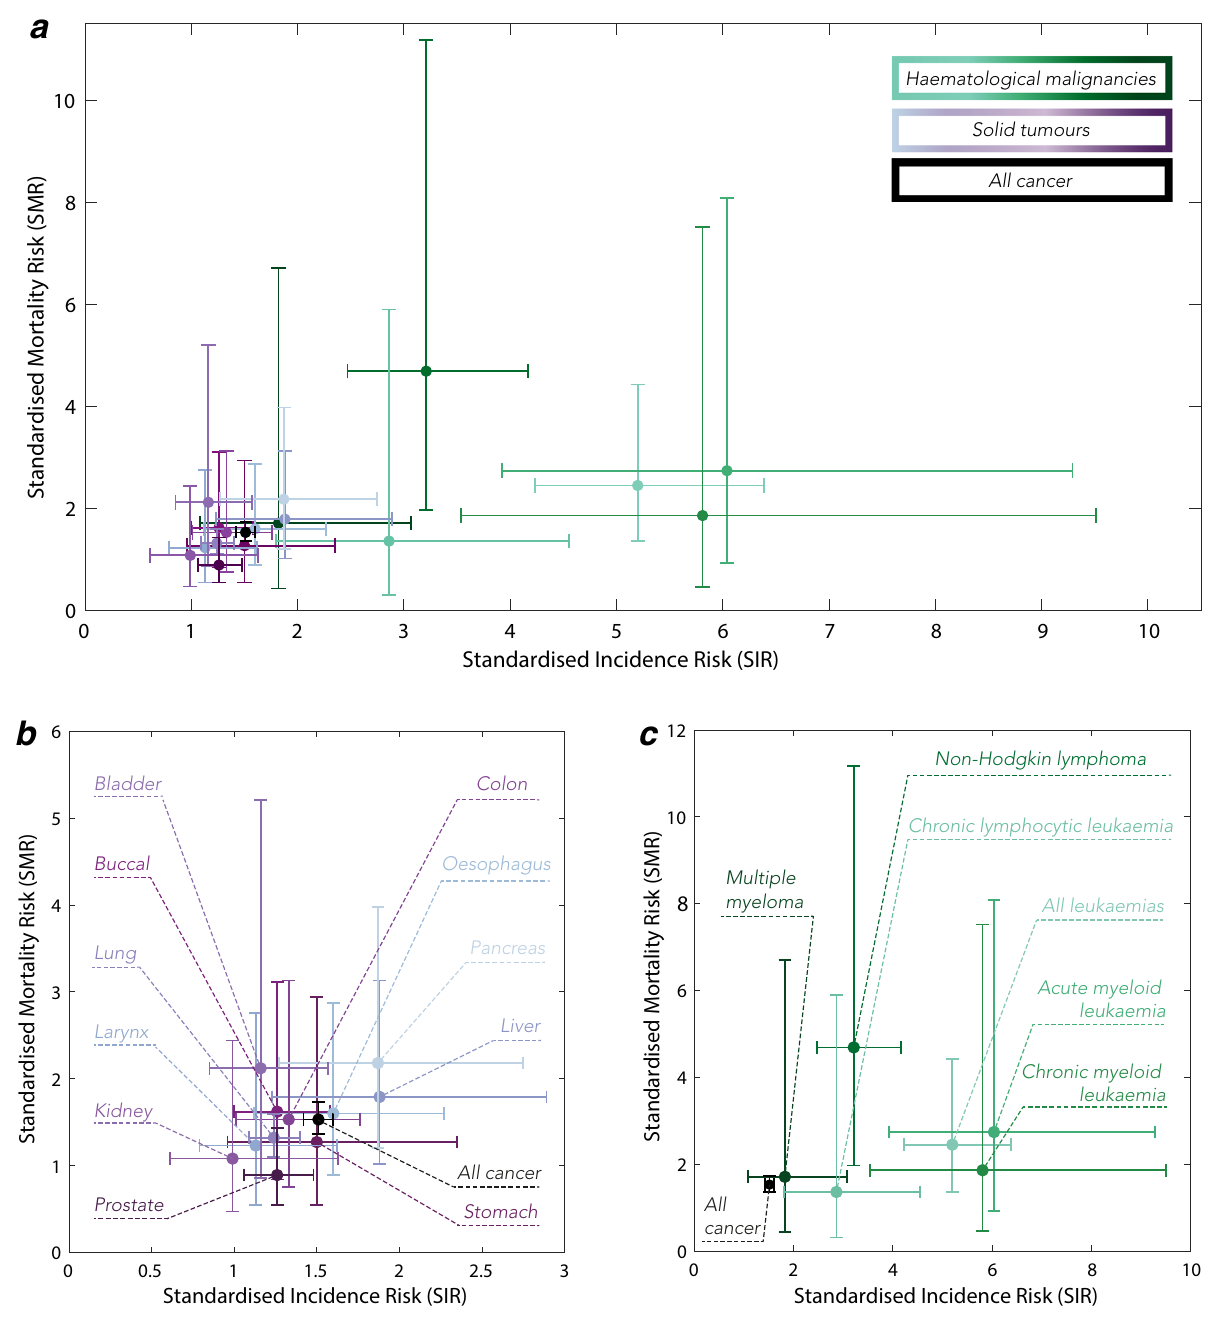
Figure 1. Standardised Incidence Ratio (SIR) and Standardised Mortality Ratio (SMR) due to selected malignancies following splenectomy as reported by Kristinsson et al. 13 . Reported malignancies were plotted on one graph ( a ) to highlight the visible distinction between solid tumours ( b ) and haematological malignancies ( c ). Cross-lines represent the reported 95% confidence intervals (95%CI). Note the difference in